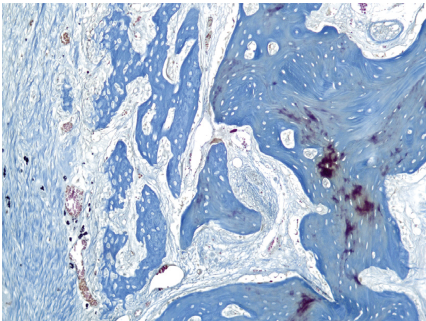
Figure 15: Histotopogram of the rabbit’s mandible cross section 4 weeks after the formation of a bone defect and introduction of a suspension of calcium hydroxide with nanodispersed cerium dioxide.